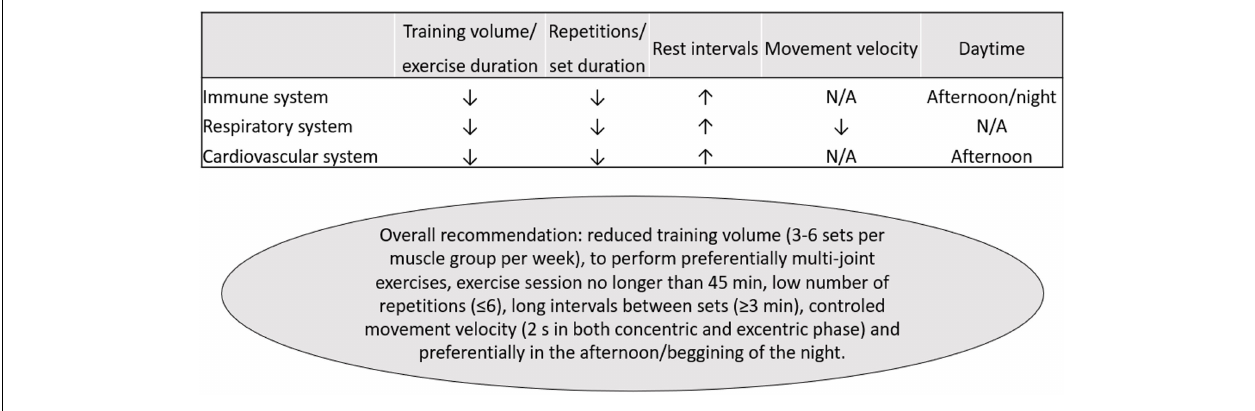
elastic devices. Therefore, equipment and implements